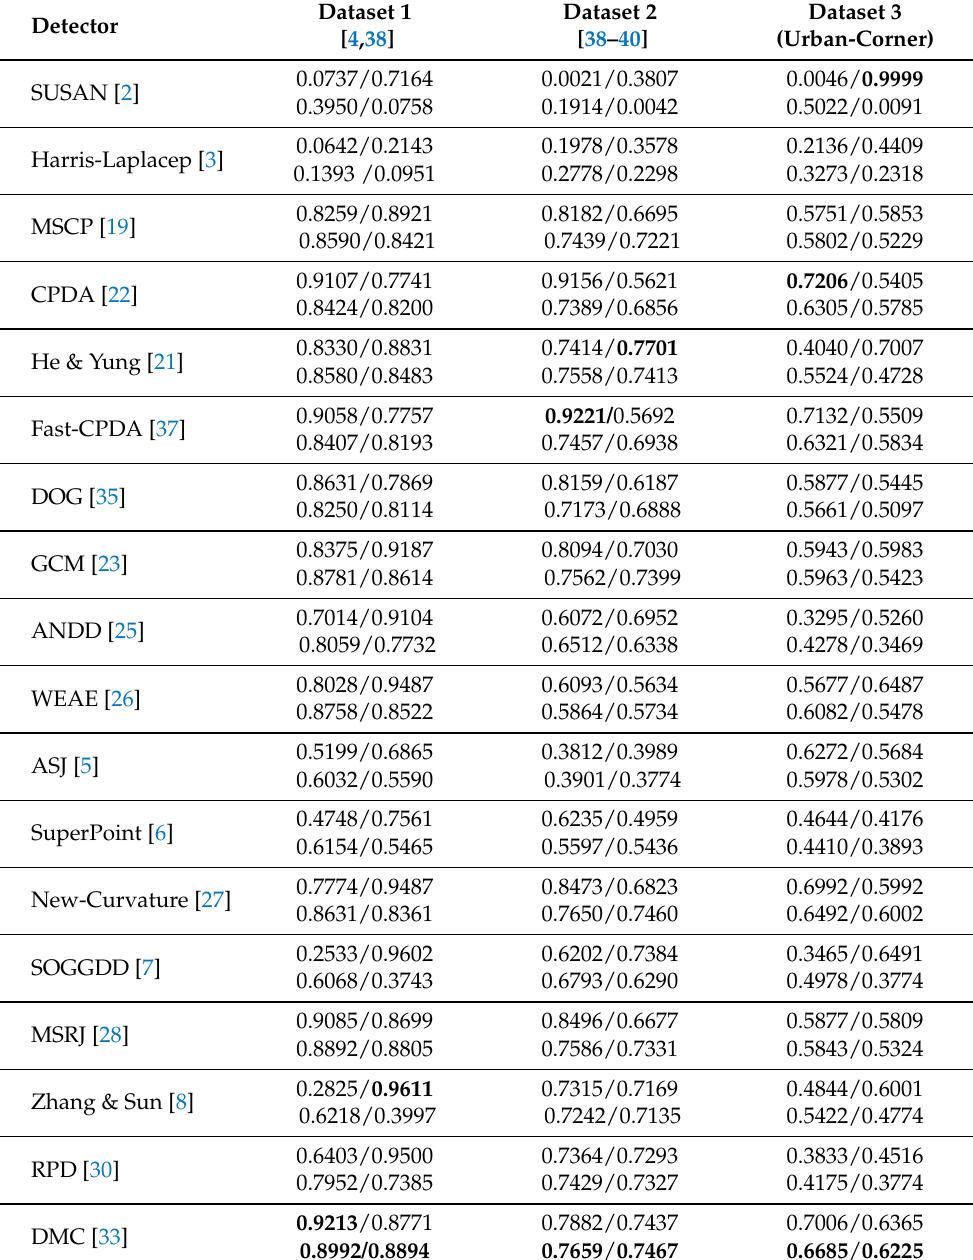
Table 2. Evaluation results in terms of precision/recall (first entry) and APR/F score (second entry) on transformed images. The highest performance with respect to each used metric achieved on each image dataset is highlighted in